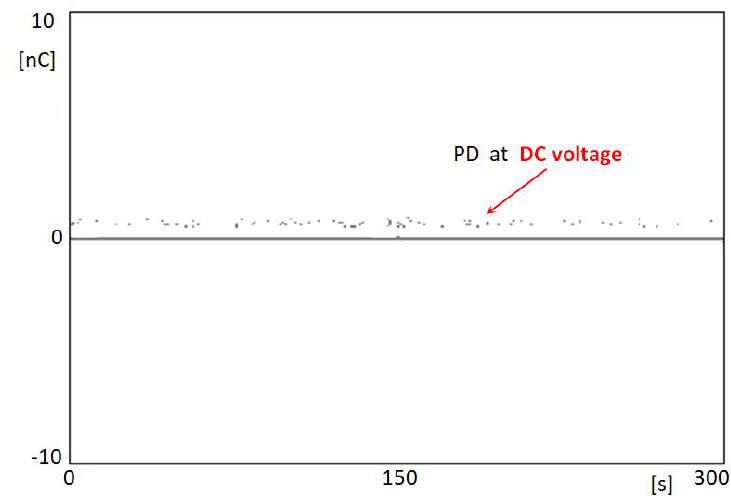
Figure 5. PD pattern at DC voltage (PD vs. time), at 10 kV; acquisition time 300 s.